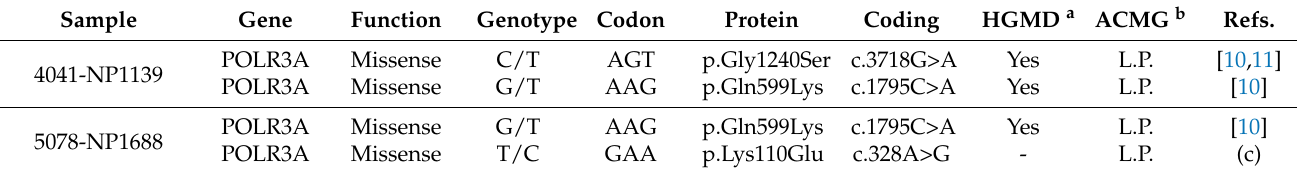
Table 2. Overview of genetic data. Table 2. Over v iew of genetic data.